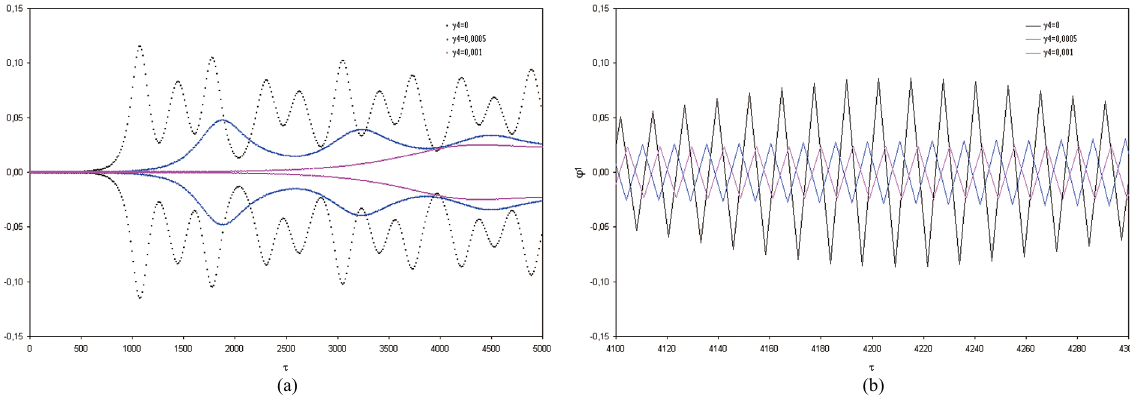
Fig. 3. Numerical solutions of ϕ 1 for different coefficients γ 4 and for a 1 = a 2 = 0.1; a 3 = 0.0001; γ 1 = 0.0001; γ 2 = γ 3 = 0; β 1 = 0.65; c = 1; u 1 = u 2 = 1.5; q = 0.1: (a) envelopes of displacements ϕ 1 , (b) time history of ϕ 1 for the region τ ∈ (4100–4300).